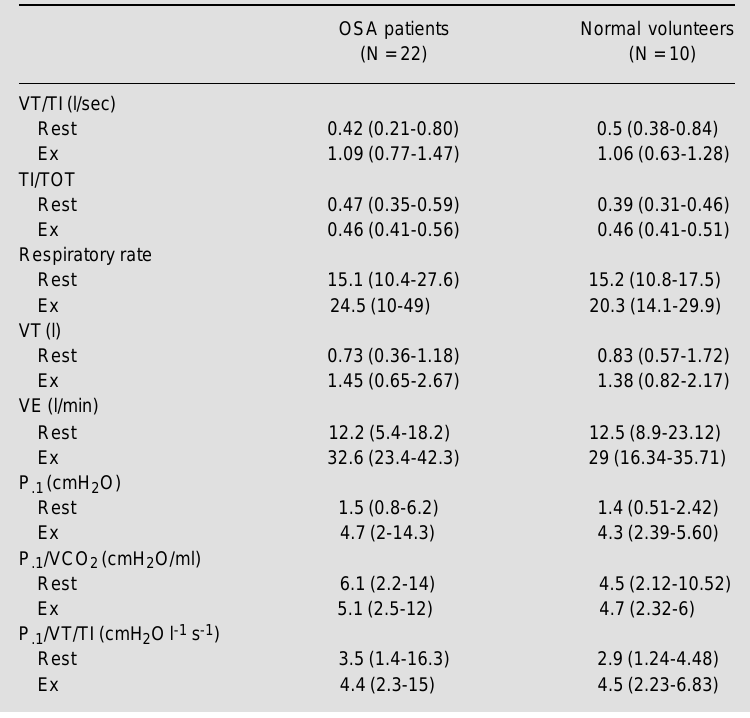
Table 3 - Ventilatory pattern, ventilatory drive and respiratory impedance in OSA patients and normal volunteers, both at rest (Rest) and during submaximal 50-Watt exercise